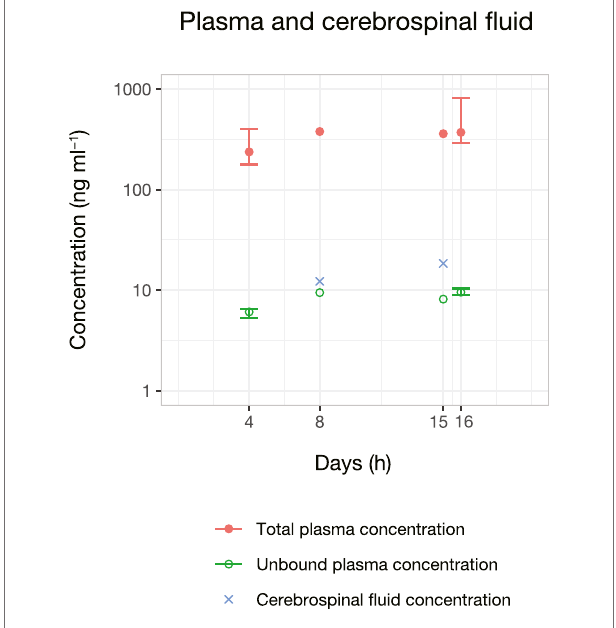
FIGURE5| AmphotericinBconcentrationsinplasmaandcerebrospinal fl uid samples versus time. Plasma samples are expressed as total and unbound concentrations. Bars (when present) represent the maximum and minimum concentrations observed during a 24 h pharmacokinetic serial sample. Unbound concentration determined in the last fi ve plasma samples collected at the terminal elimination time as described in Figure 1 .